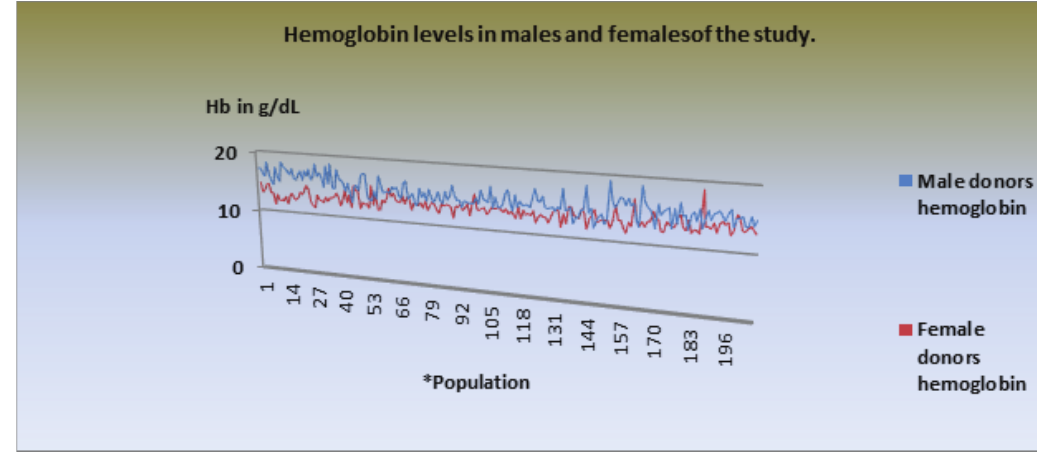
Figure 2: A line chart representing the hemoglobin levels in males and females of the study population. *Population limitation is from the software. TABLE 3: Correlations ofthe weight and age to both RBCs count and hemoglobin